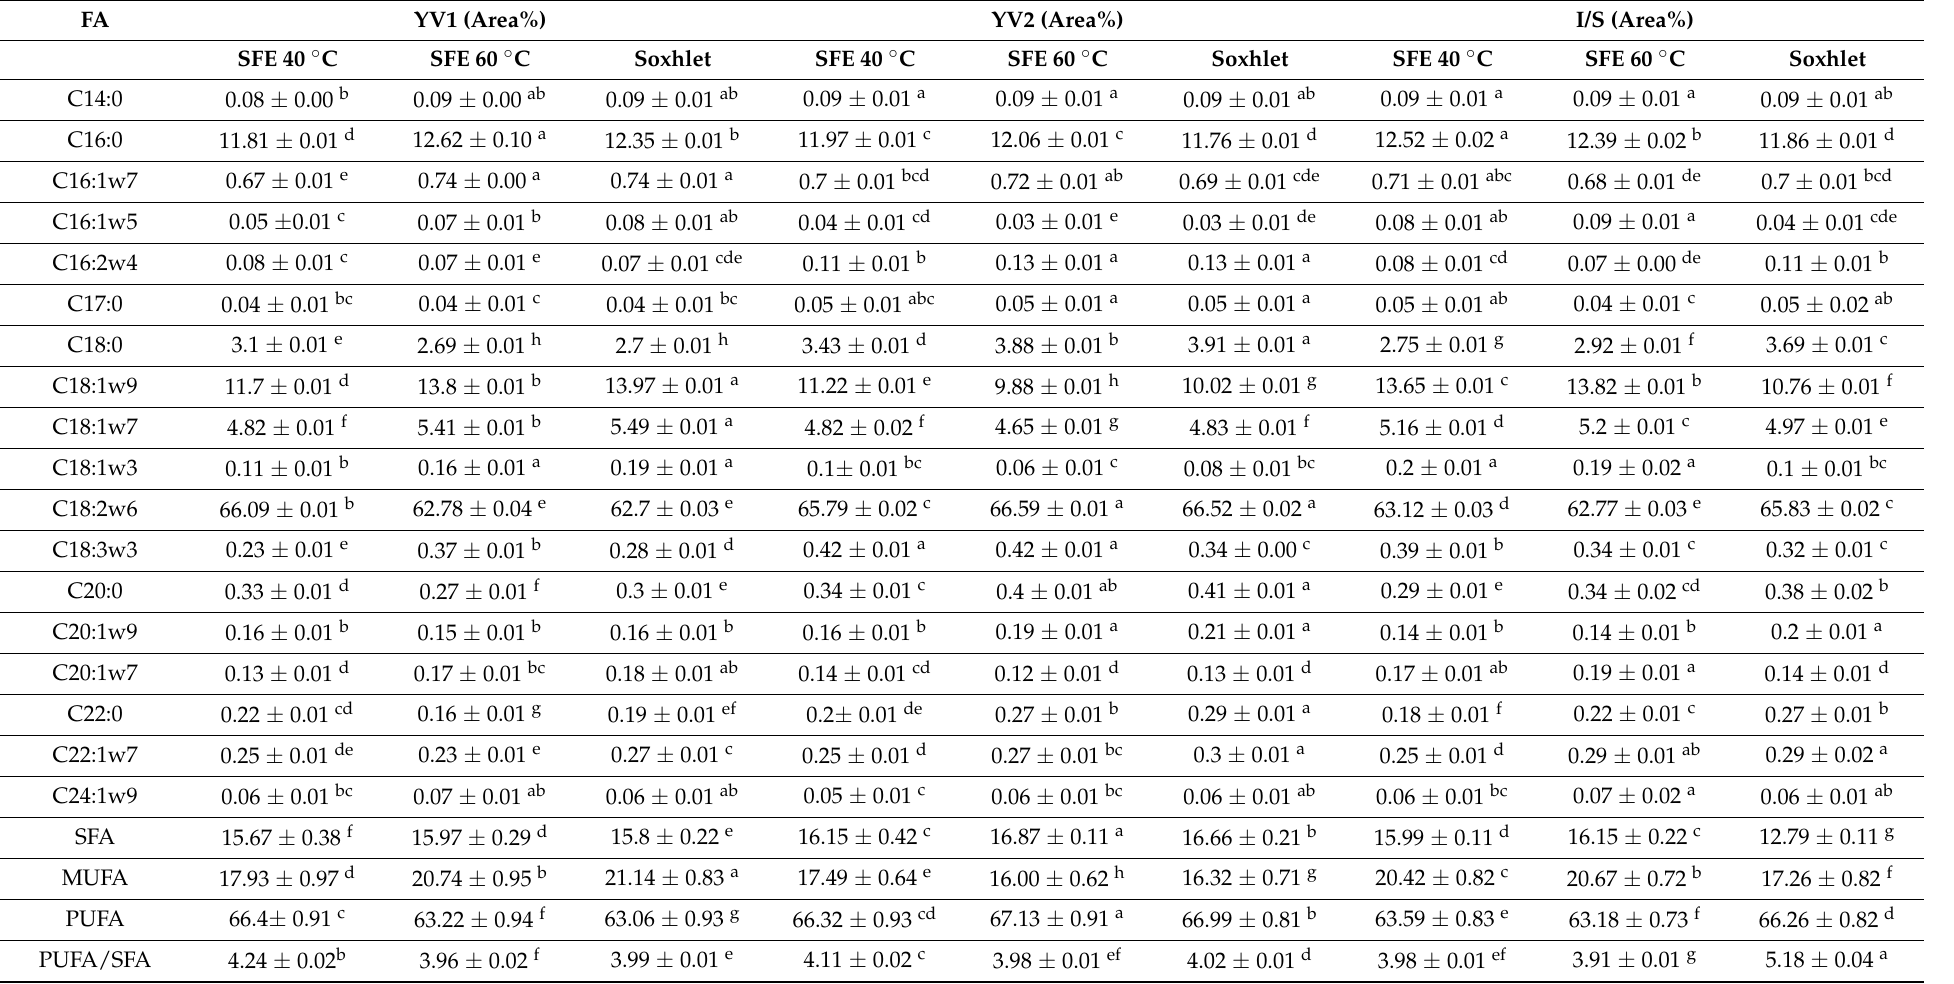
Table 1. Fatty acid (FA) composition of YV1, YV2, and I/S seed oils extracted using SFE and Soxhlet